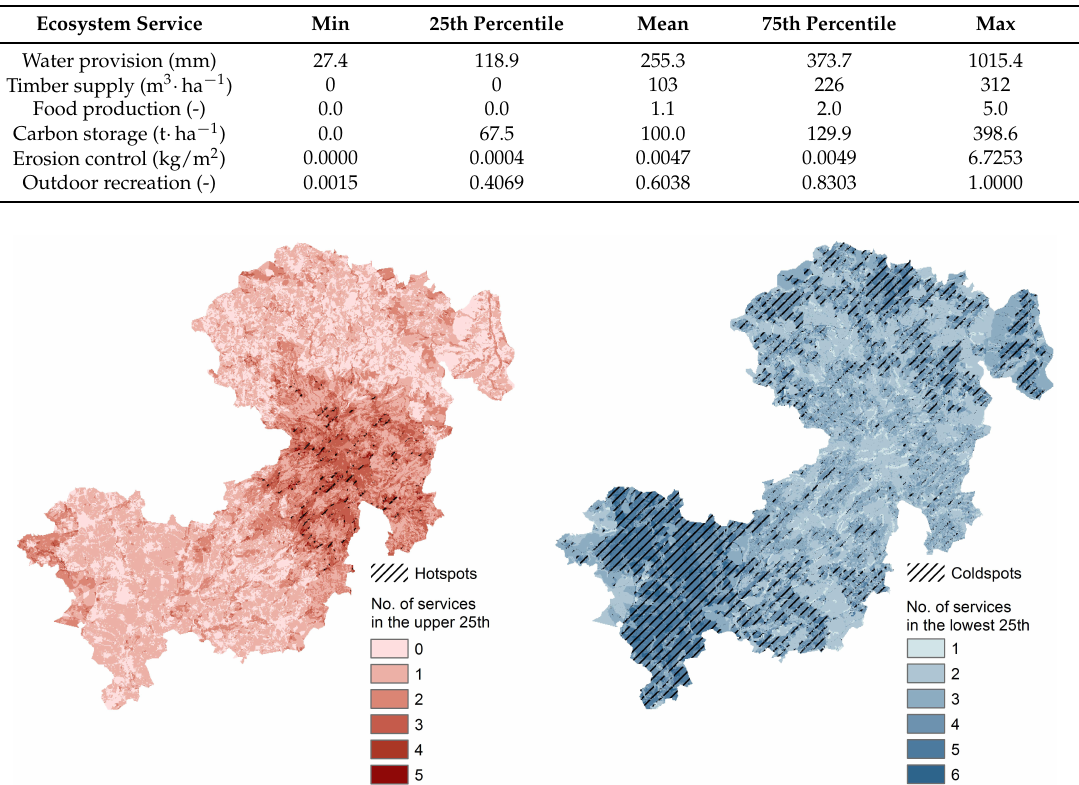
Figure 3. Maps of hotspots and coldspots for the supply of multiple ecosystem services: ( a ) hotspots where four or more services were in the upper 25th percentile and number of ecosystem services in the upper 25th percentile; ( b ) coldspots where four or more services were in the lowest 25th percentile and number of ecosystem services in the lower 25th